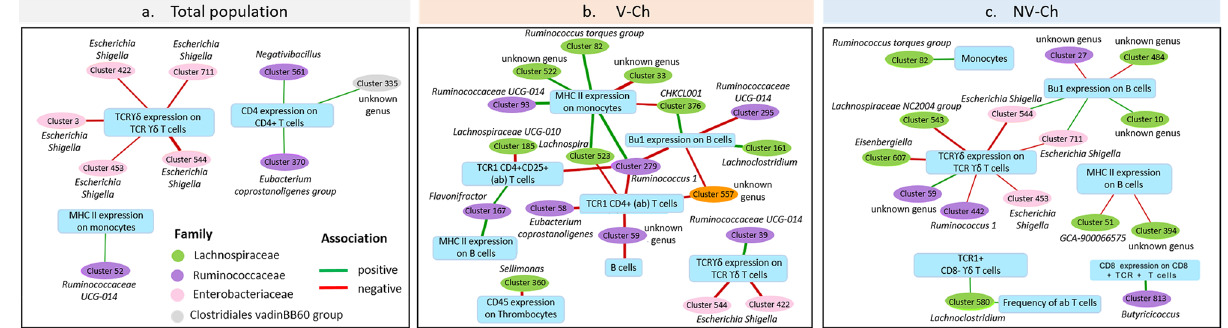
Figure 5. Network representing the associations observed between the immune parameters and the OTU abundances in laying hens, one week after their infection with IBV. Associations were calculated with Spearman correlation in ( a ) the total population, ( b ) the vaccinated and challenged (V-Ch) group, and (c) the non- vaccinated and challenged (NV-Ch) group, with positive associations represented with green segments, and negatives ones with red segments. Only significant (p < 0.05), intermediate (total population: 0.4 < r < 0.6; V-Ch and NV-Ch groups: 0.5 < r < 0.7) and high (r > 0.6, thick segments) correlations are